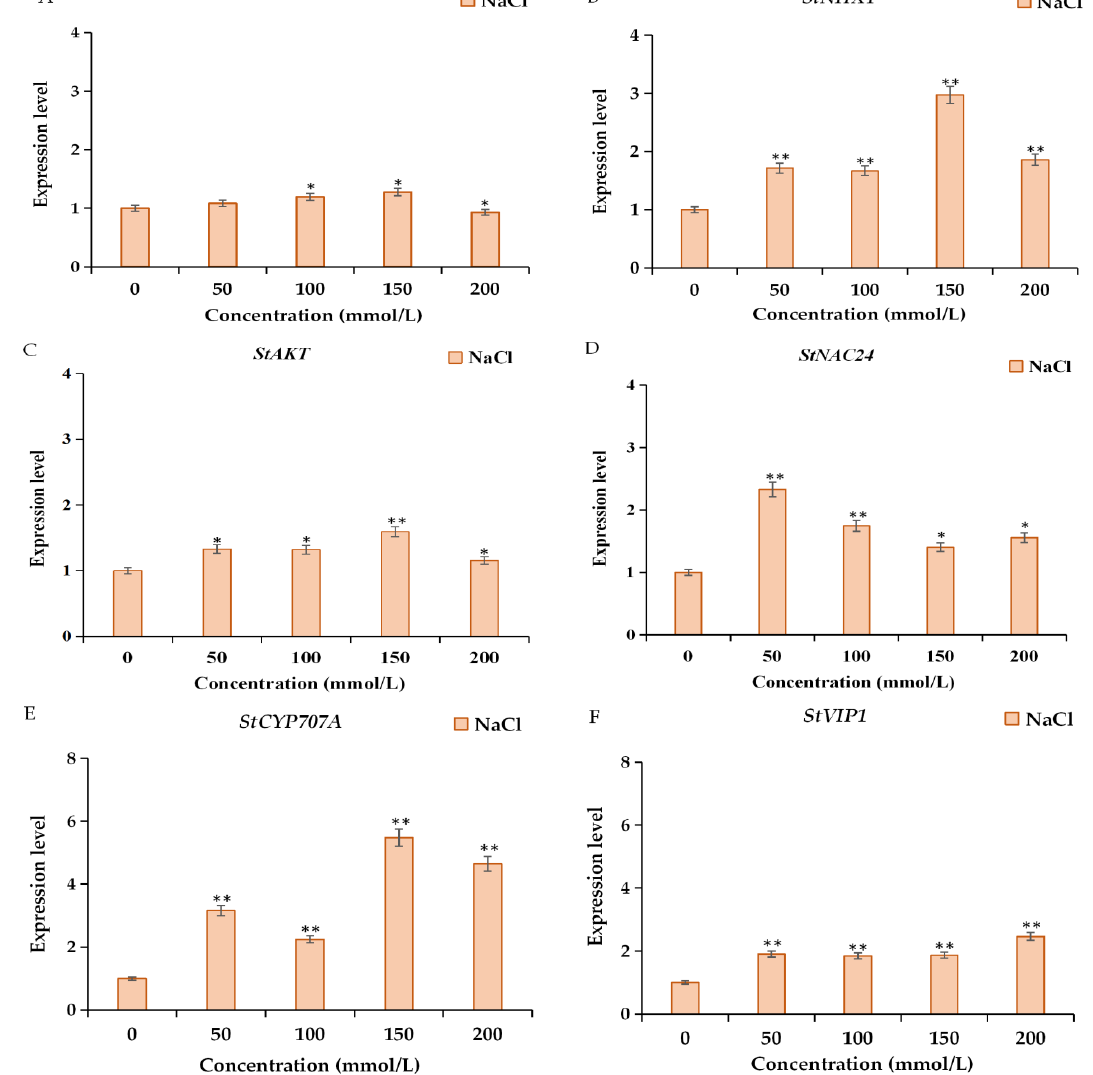
Figure 6. The expression level of ion transport-related genes and transcription factors under different concentration NaCl at 24 h. ( A ), ( B ), ( C ), ( D ), ( E ), and ( F ) were the expression levels of StSOS1, StNHX4, StAKT, StNAC24, StCYP707A, and StVIP1, respectively. * and ** represent significant and very significant differences, respectively. StSOS1, a membranous Na + /H + reverse transporter 1; StNHX4, a possible vacuolar Na + /H + exchanger 4; StAKT, K + transporter; StNAC24, NAC transcription factor 24; StCYP707A, (+)- Abscisic Acid 8′ -Hydroxylase; StVIP1, Vire2-interacting protein 1.